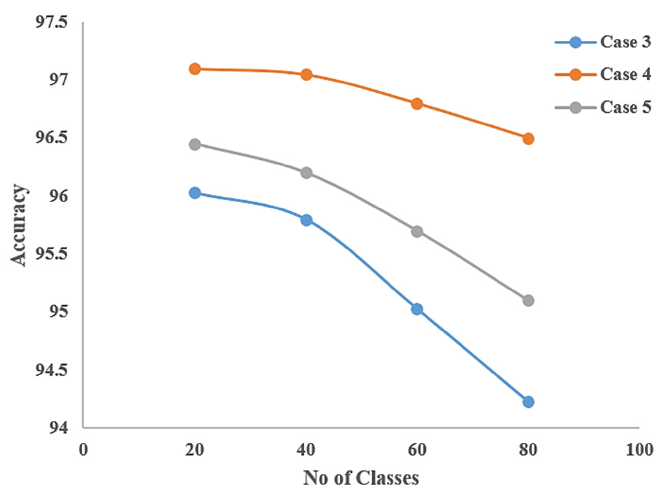
Figure 14. Five-fold cross-validation.